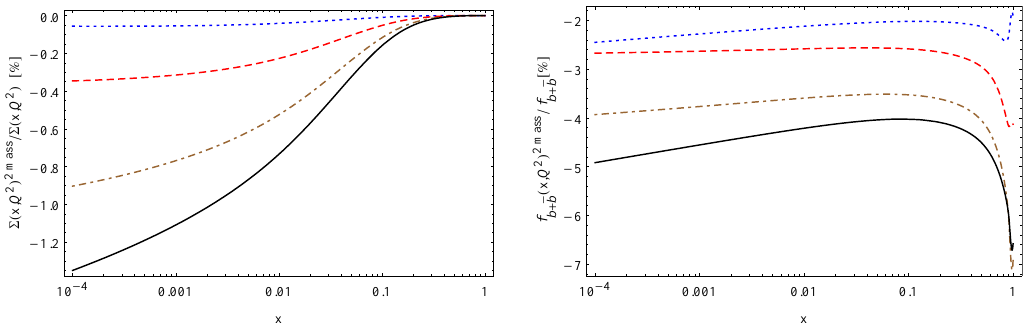
Figure 3: The ratio of the 2-mass contributions to the singlet parton distribution Σ ( x , Q 2 ) in the on-shell